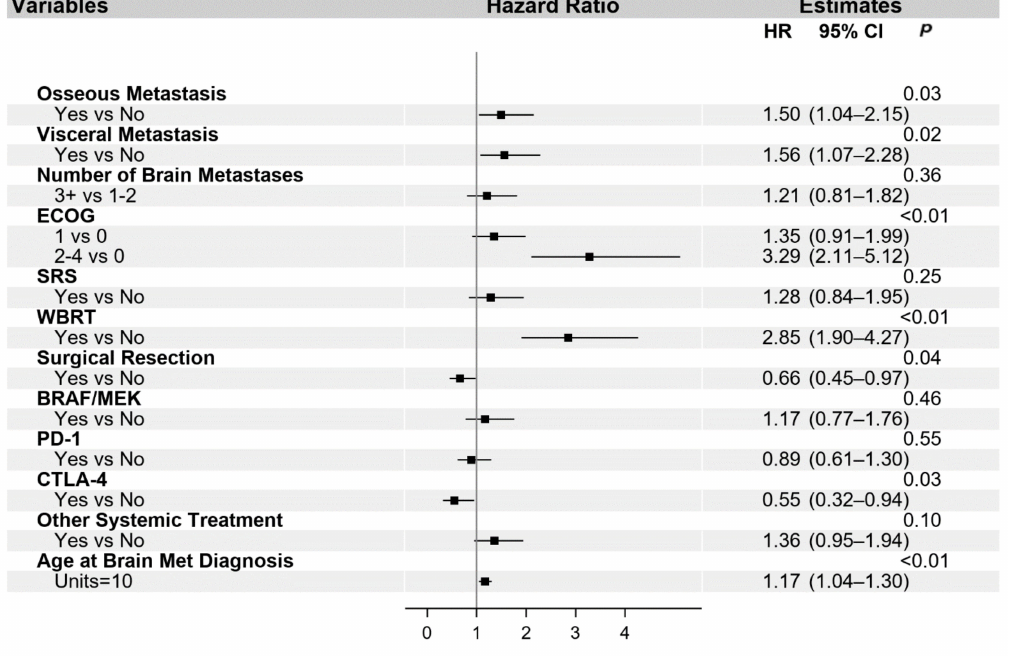
Figure 2. Multivariable analysis of overall survival. Abbreviated variable names include Eastern Cooperative Oncol- ogy Group performance status (ECOG), stereotactic radiosurgery (SRS), whole-brain radiation therapy (WBRT), and metastasis